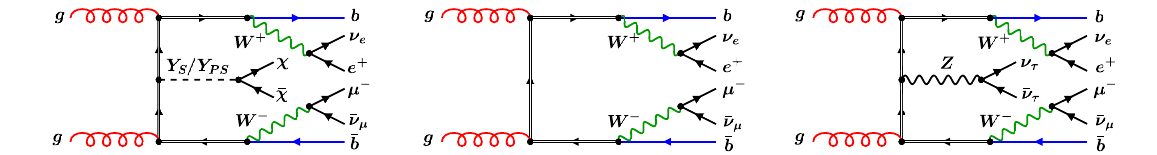
Fig. 1 Leading order Feynman diagrams for the signal process (left) as well as for the two dominant background processes, t ¯ t (center) and t ¯ tZ